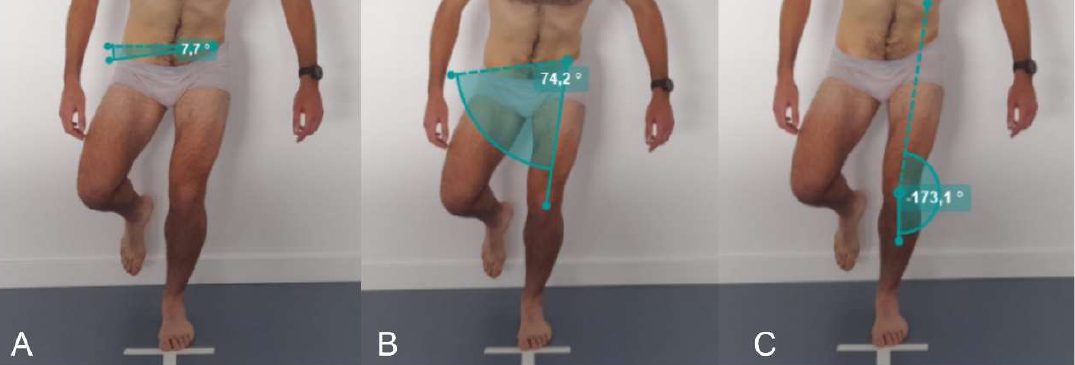
Figure 1. ( A ) Kinovea analysis of the contralateral pelvic drop angle; ( B ) Kinovea analysis of the Figure 1. ( a ) Kinovea analysis of the contralateral pelvic drop angle; ( b ) Kinovea analysis of the femoral adduction angle; ( C ) Kinovea analysis of the knee valgus angle. femoral adduction angle; ( c ) Kinovea analysis of the knee valgus angle. Table 1. Test-retest reliability of the study